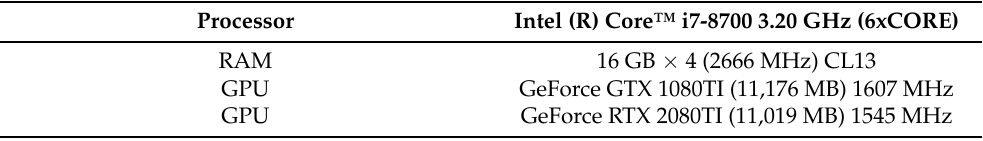
Table 2. Hardware specification of training machine.